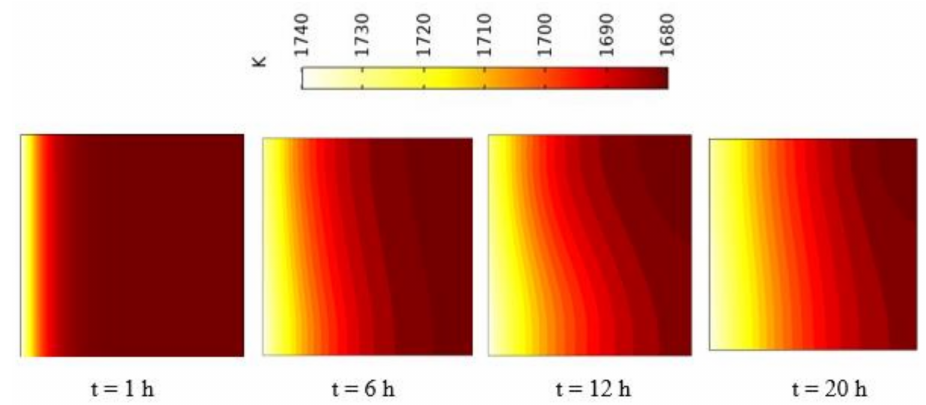
Figure 5. Temporal distribution of temperature during charging.